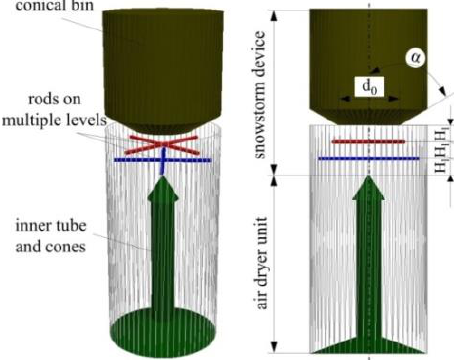
Fig. 2. Geometrical model of the air dryer unit and the snowstorm filler